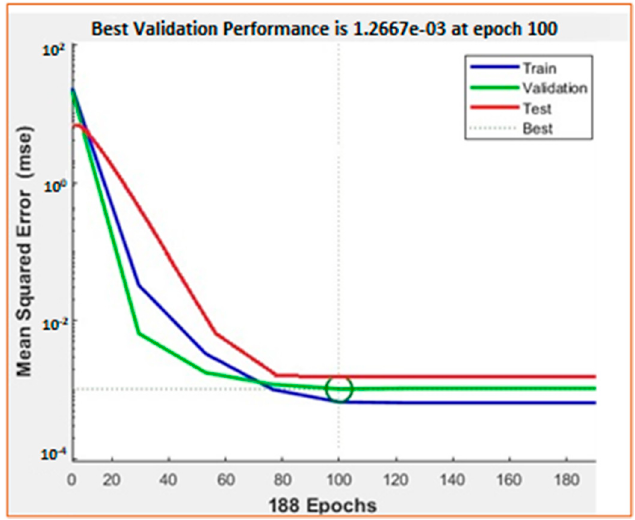
Figure 15. The curve of performance of the developed model is indicated by the mean squared error (MSE) vs. the number of epochs. (MSE) vs. the number of